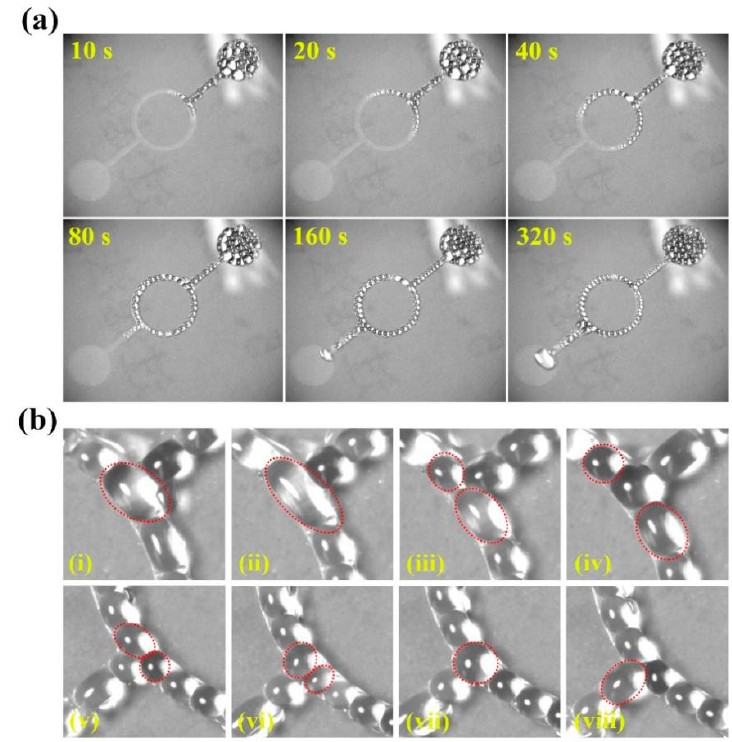
Figure 5. The dielectric droplets flow along curved microchannels. ( a ) Photographic sequences of the evolution of dielectric droplets in curved microchannels ( b ) The split of droplets at the beginning of circular channel (i), (ii), (iii) and (iv), the coalescence of droplets at the end of circular channel (v), (vi), (vii) and (viii).